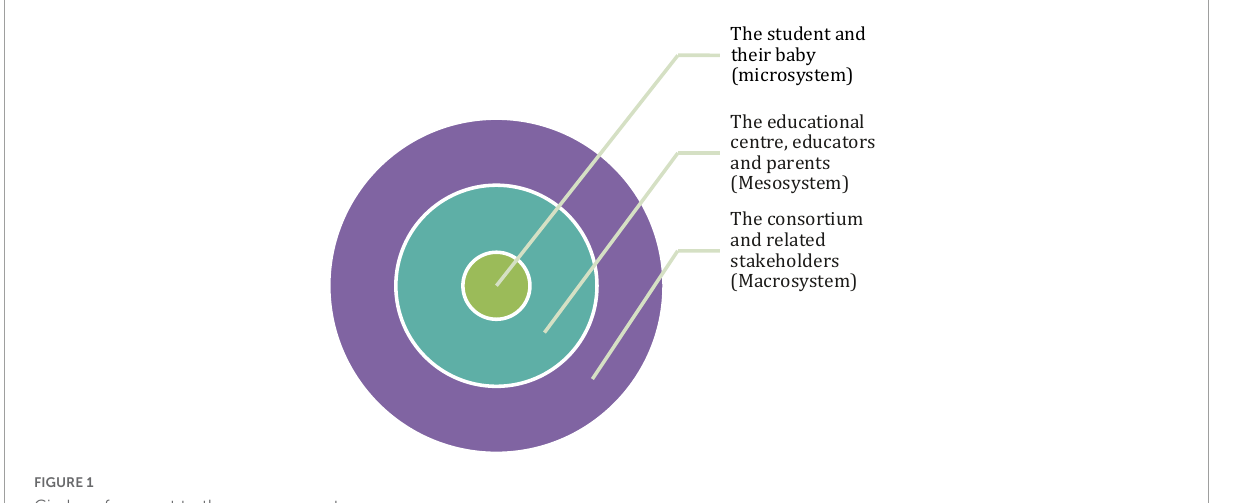
FIGURE1 Circles of support to the young